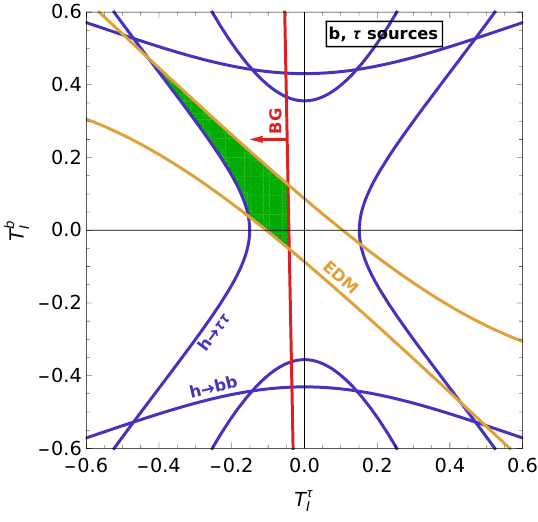
Figure 3 . Constraints on b and (cid:28) sources with T b;(cid:28) = 0 from the LHC (blue), the eEDM (yellow) R and Y B (red). The parameter space allowed by all three constraints is highlighted in green. Collider range allowed by (cid:22) = 0 : 91 (cid:6) 0 : 13 and (cid:22) = 1 : 02 (cid:6) 0 : 14, with (cid:22) F given by equation (cid:28) + (cid:28) (cid:0) b (cid:22) b I